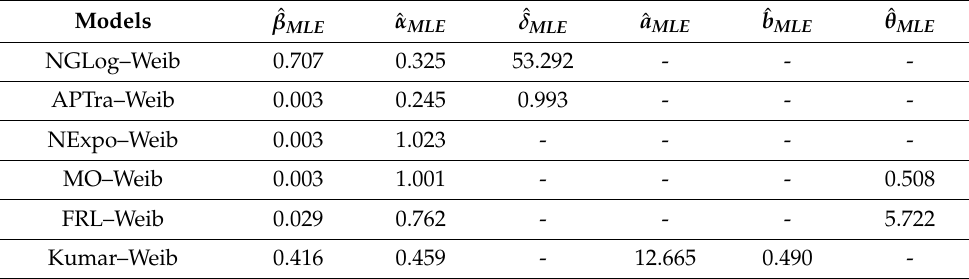
Table 10. The GFMs and p -values of the competing models for head and neck cancer data (dataset 2).